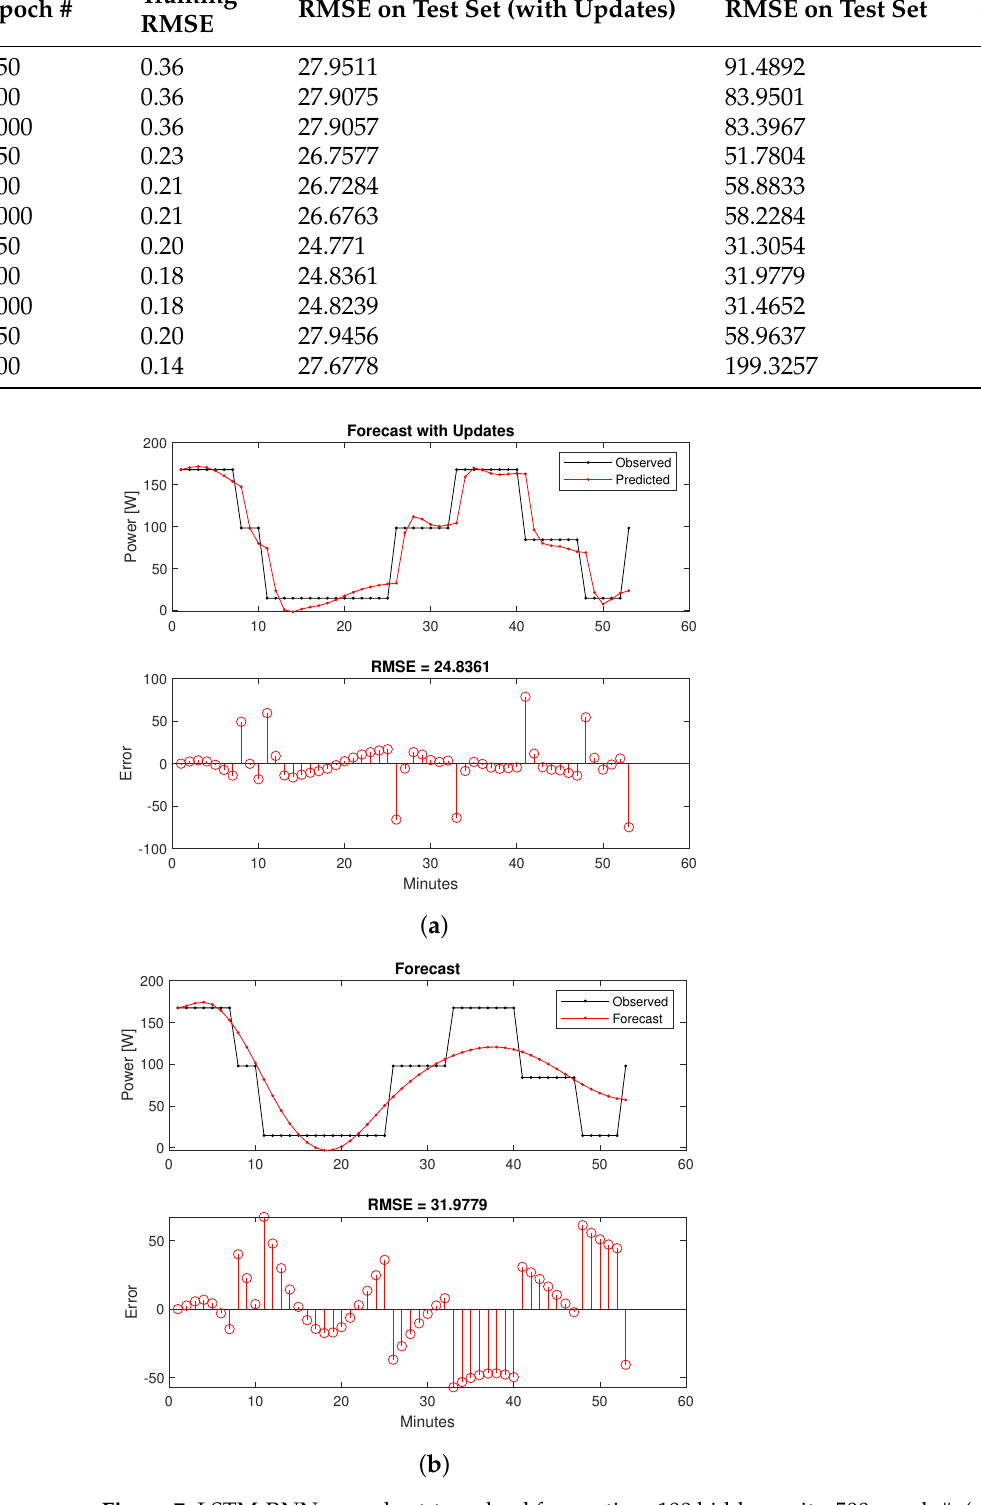
Figure 7. LSTM-RNN very short-term load forecasting: 100 hidden units, 500 epoch #. ( a ) Updated with observed values. ( b ) Updated with predicted